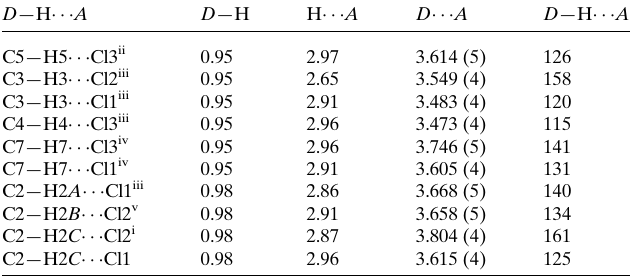
Table 2 Hydrogen-bond geometry (A˚ , (cid:2) ).